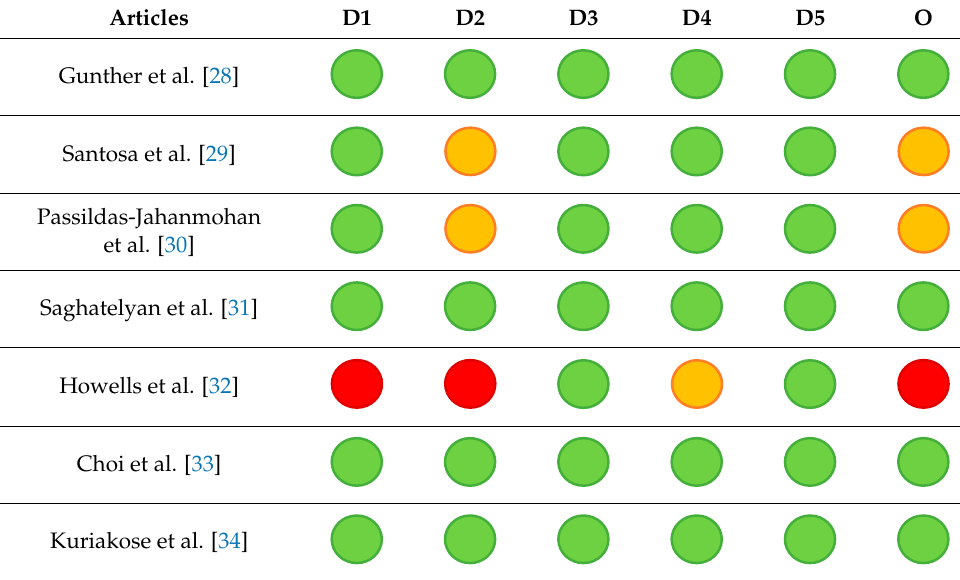
Table 3. Quality assessment and risk of bias in the analyzed RCTs.